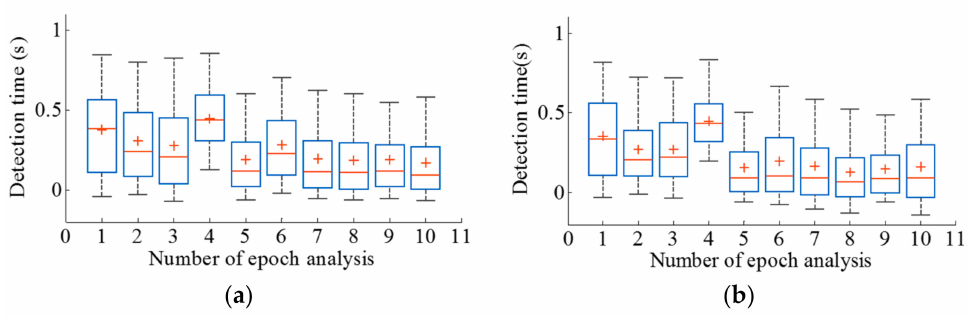
Figure 6. Box plots for detection times obtained from both algorithms: ( a ) ELM classifier; ( b ) MLP classifier.